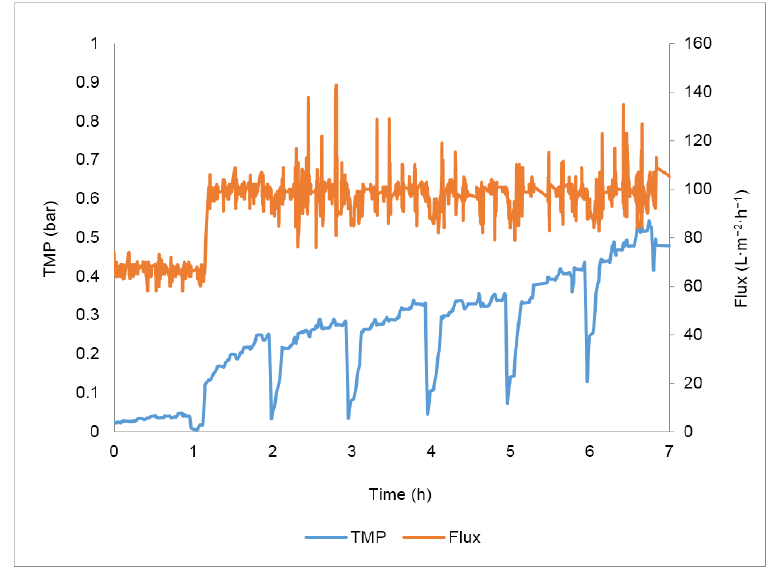
Figure 5. Transmembrane pressure (TMP) and permeate flux profiles obtained in the concentration test.